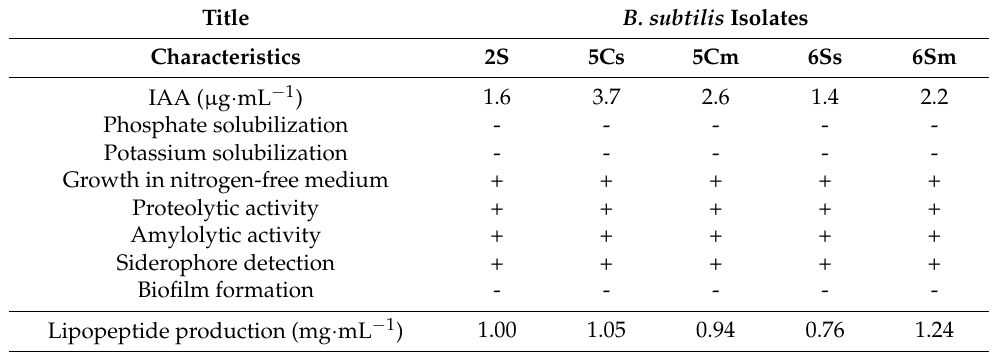
Table 4. Metabolic characterization of endophytic bacteria strains as relates to the promotion of plant